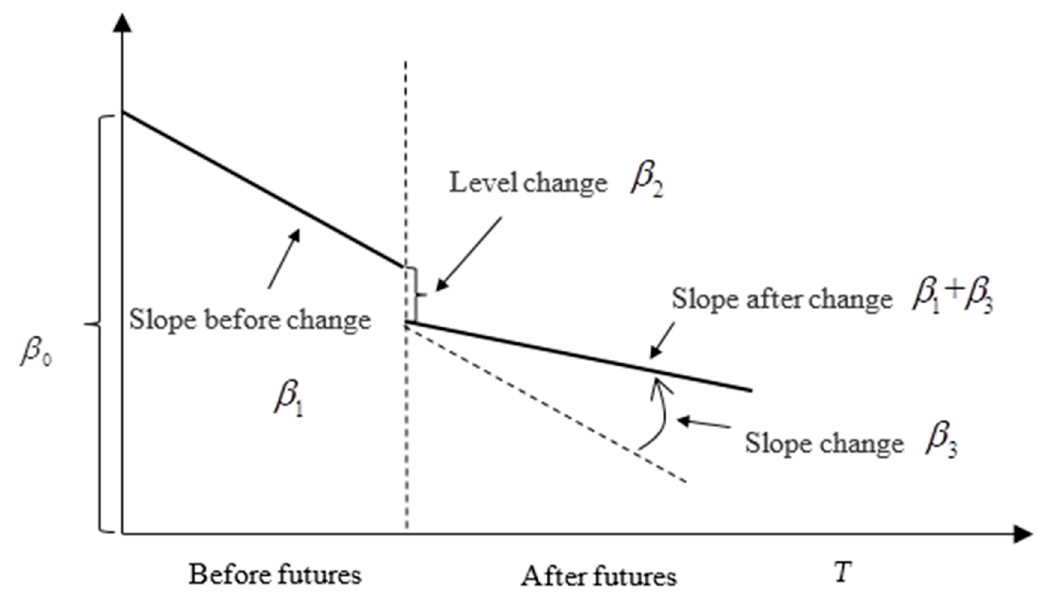
Figure 1. Interrupted time-series analysis (ITSA) schematic.